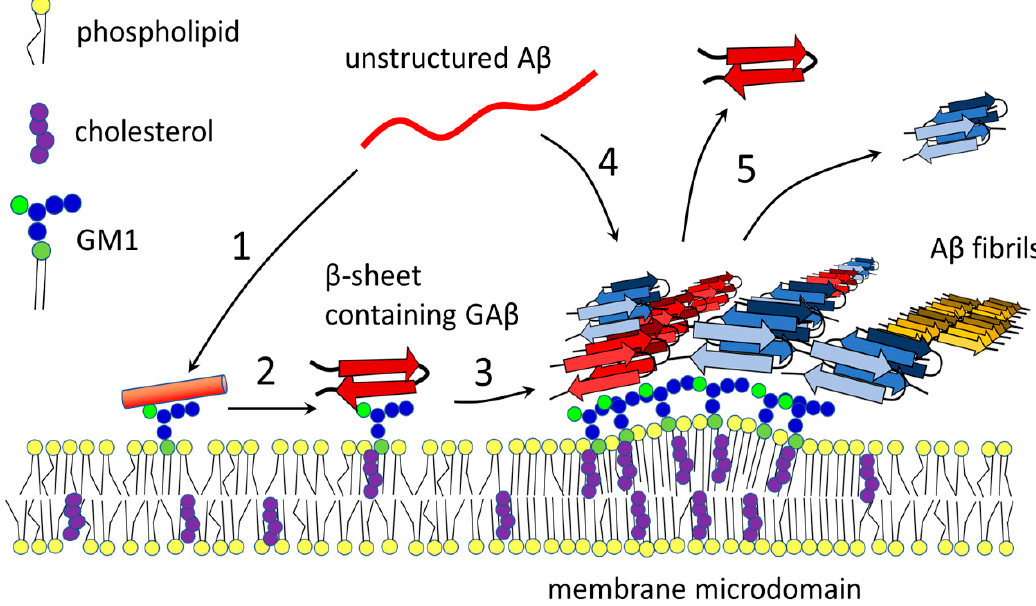
Figure 3. Aggregation of amyloid β on GM1-containing membrane. After processing of APP, A β (red) is released into intercellular space. Certain membrane molecules, including ganglioside GM1, serve as nucleation centers for A β aggregation. (1) Binding to non-clustered GM1 induces α -helical conformation in A β . (2) GM1 causes transition of α -helical to β -sheet structure. (3) Clusters of GM1 localized to membrane microdomains are responsible for concentration and aggregation of amyloid peptide into higher-molecular forms. Both parallel and antiparallel β -structures were observed in membrane bound amyloid fibrils. (4) Aggregates of A β serve as platforms for capturing and binding of monomers or oligomers circulating in the intercellular space. On the other hand, some portion of amyloid peptides may release from the aggregates (5). Adjusted according to [66,85,92,153,155].